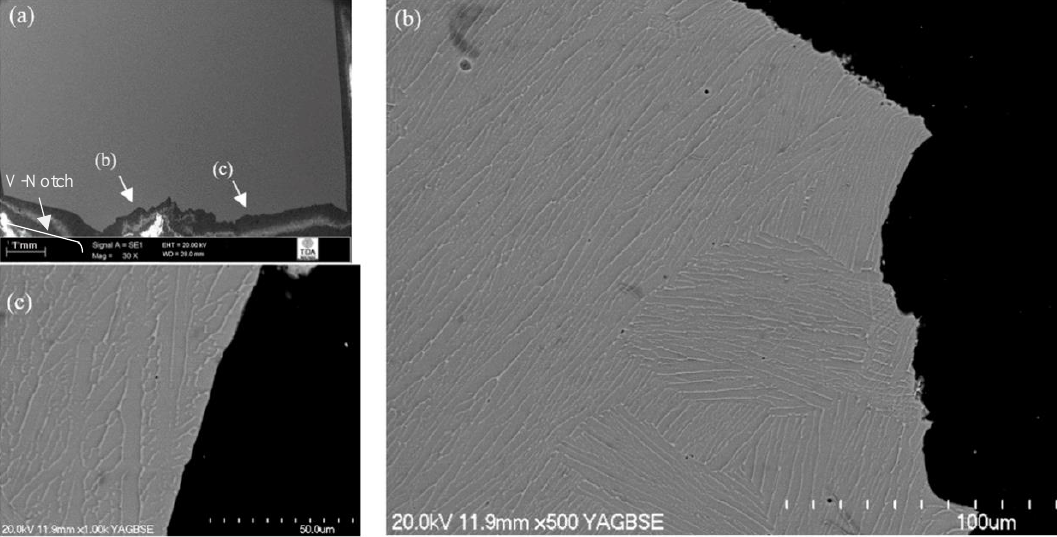
Figure 4. Crack propagation behaviour of 1200 °C/30 min, FC, 730 °C/2 h heat-treated material: ( a ) overall crack path; ( b ) crack path in first half; ( c ) crack propagation in second half (relative location of image ( b ) and ( c ) is marked on ( a )).